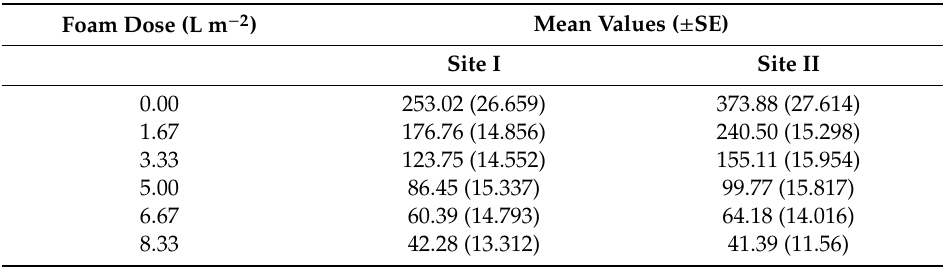
Table8. Meanvaluesandstandarderrors(SE)estimatedfromtheexponentialdecaymodel(Equation(3)) of the weed dry biomass as a ff ected by the di ff erent foam doses (0, 1.67, 3.33, 5.00, 6.67 and 8.33 L m − 2 , respectively) and the site at 37 days after the treatment in the Taraxacum o ffi cinale (Weber) and Plantago lanceolata (L.) infested field experiment. The non-linear regression curves are plotted in Figure